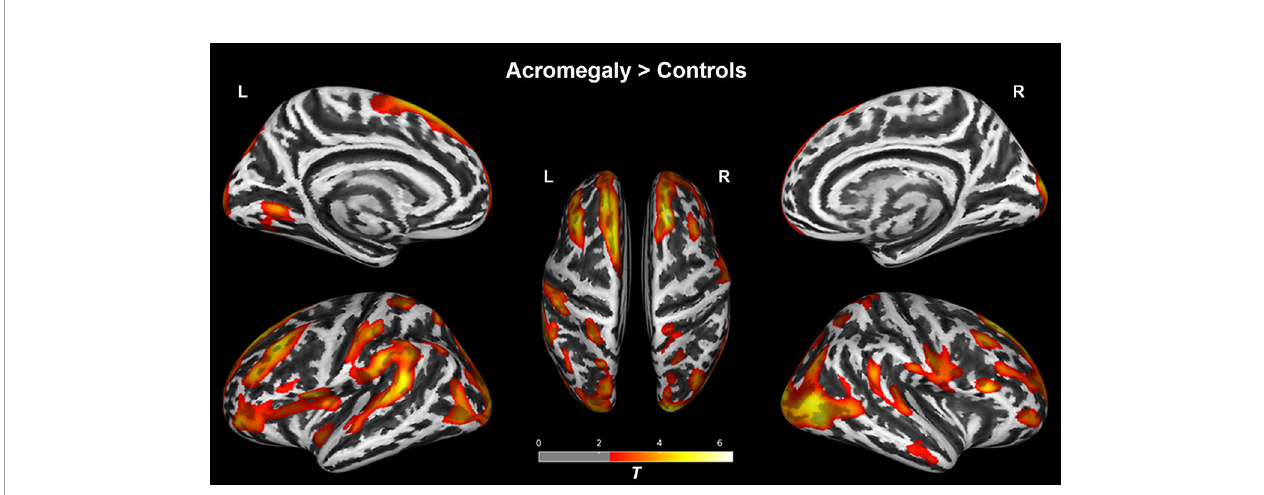
FIGURE 1 | Results of the surface-based morphometry (thickness) analysis between acromegaly and controls. Red-yellow indicates the cortical thickness with signi fi cantly increased in acromegaly compared to controls. (pFDR < 0.05). L, left hemisphere; R, right